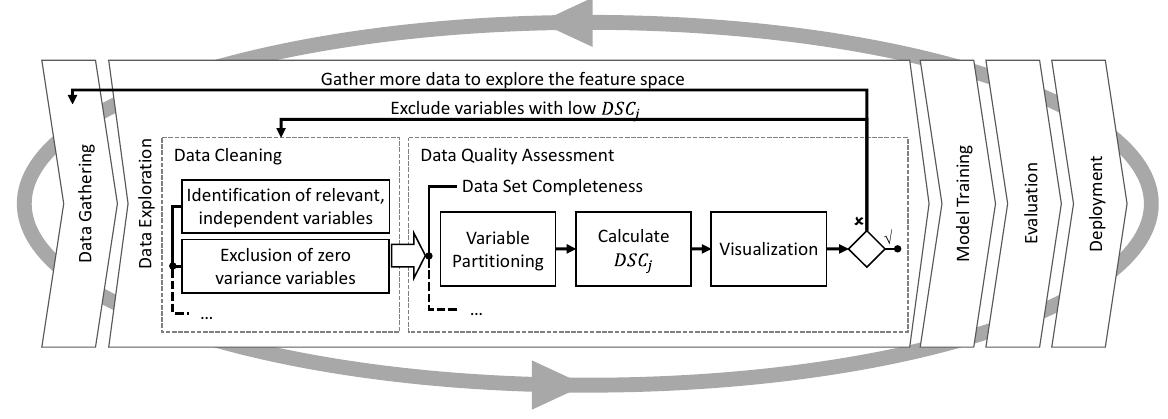
Figure 8. Workflow for the assessment of data set completeness in sensor and actuator data of aPSs.